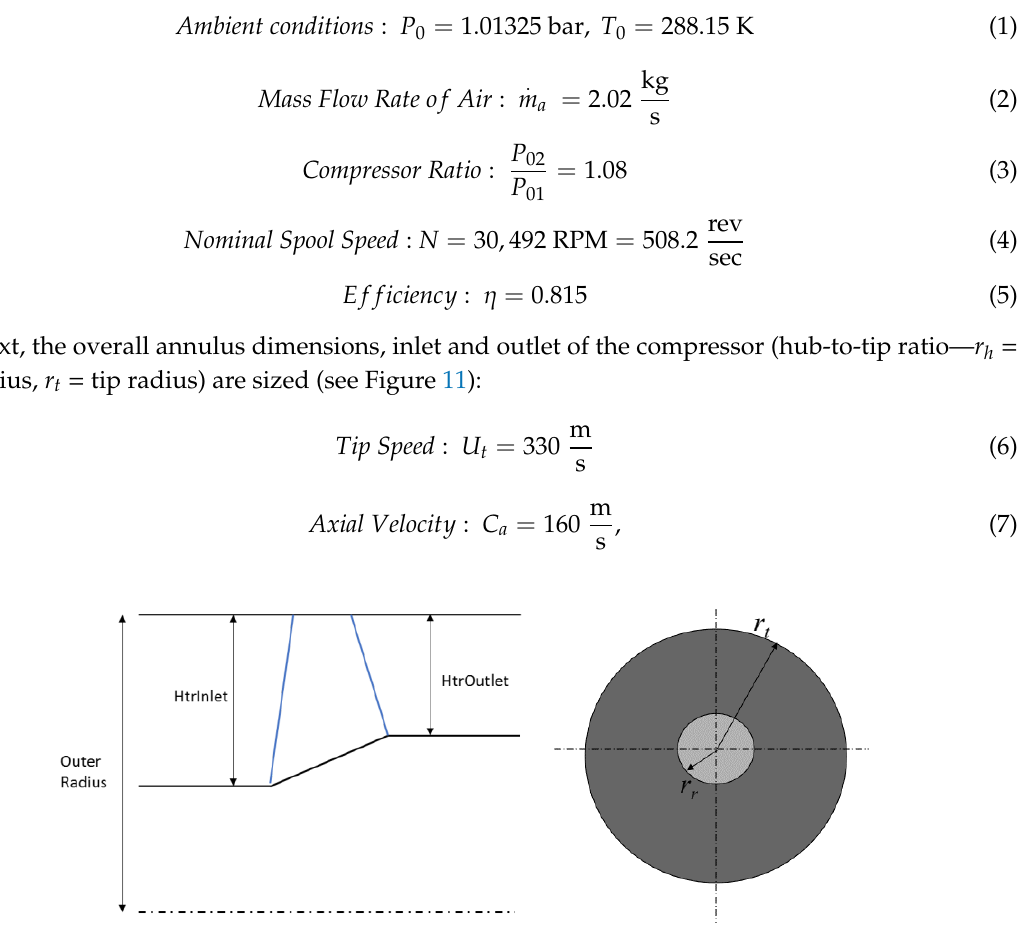
Figure 11. Diagram explaining the geometry input parameters.